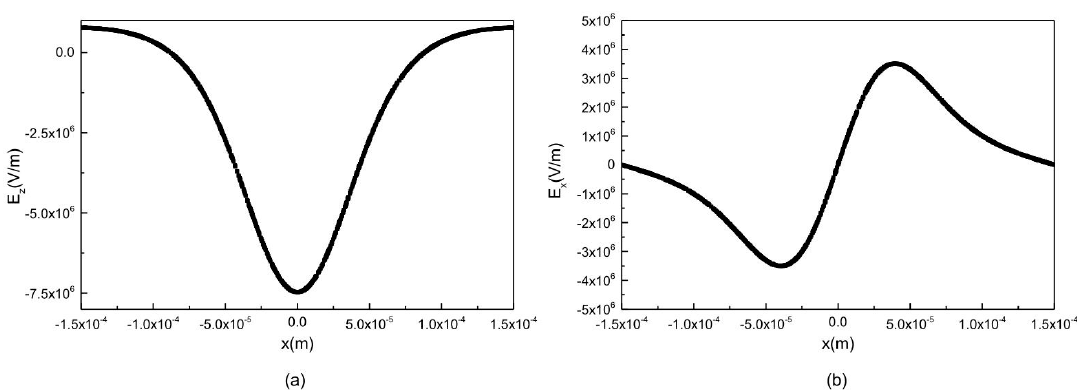
Figure 2. Light-induced electric field components in correspondence of the middle of the LC layer (z = L/2) as a function of the distance x from the peak of the Gaussian beam waist. The used data are: LC: thickness 50 μ m, ε e = 14.5, ε o = 5.1; LiNbO 3 : thickness 900 μ m, ε e = 29, ε o = 85. ( a ) Field component perpendicular to the substrate; ( b ) field component parallel to the substrate.